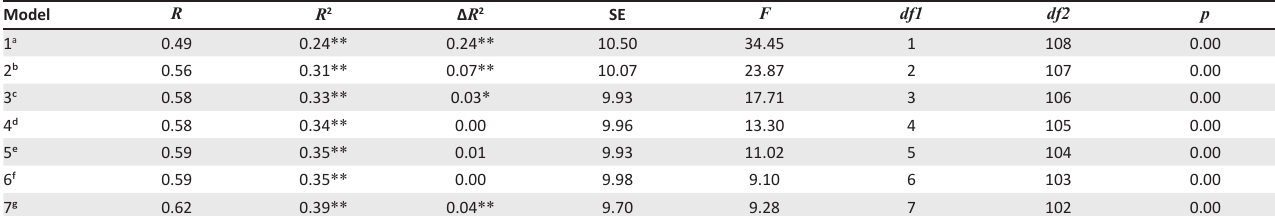
TABLE 1: Multiple regression analyses for variables predicting emotional exhaustion. Model